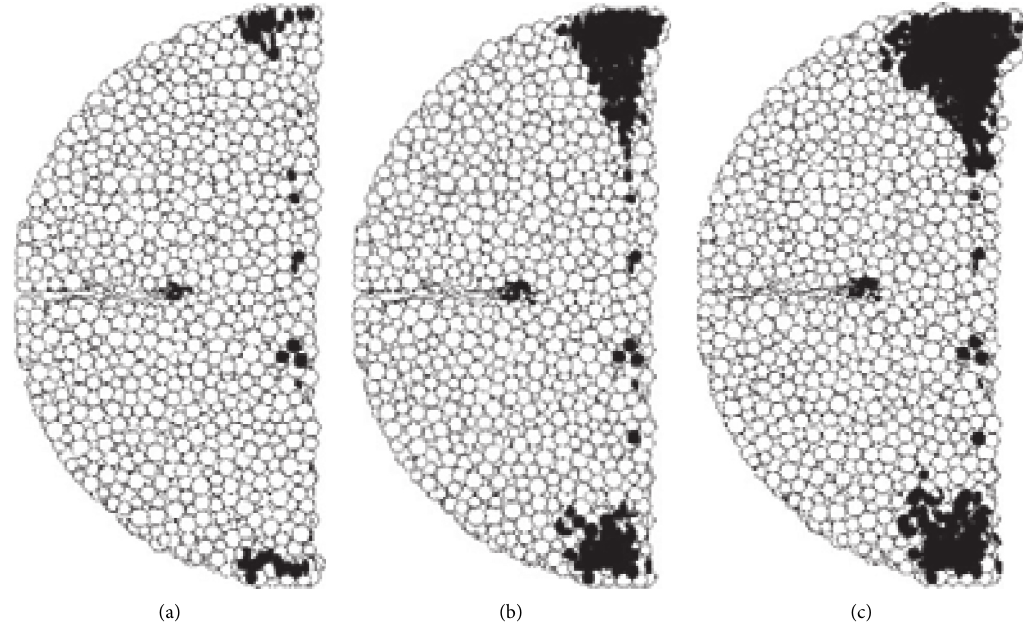
Figure 16: Microcracks distribution in ECFSD specimen (A2). (a) Crack initiation. (b) Crack growth. (c) Sample failure.